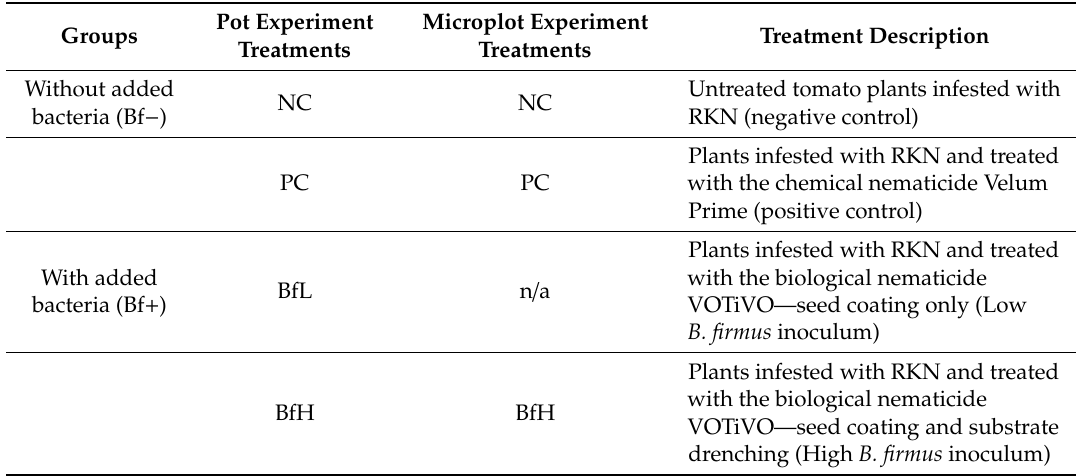
Table 7. Experimental design of the pot and microplot experiments and treatment group designations. Pot Experiment Microplot Experiment Treatment Description Groups Treatments Treatments Without added Untreated tomato plants infested with NC NC bacteria (Bf − ) RKN (negative control) Plants infested with RKN and treated PC PC with the chemical nematicide Velum Prime (positive control) With